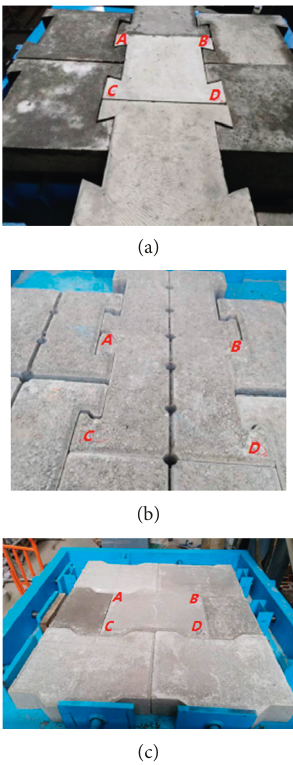
Figure 3: The arrangement of three types of blocks. (a) H-type gravity mutual-aid block. (b) Traditional block 1. (c) Traditional block 2.